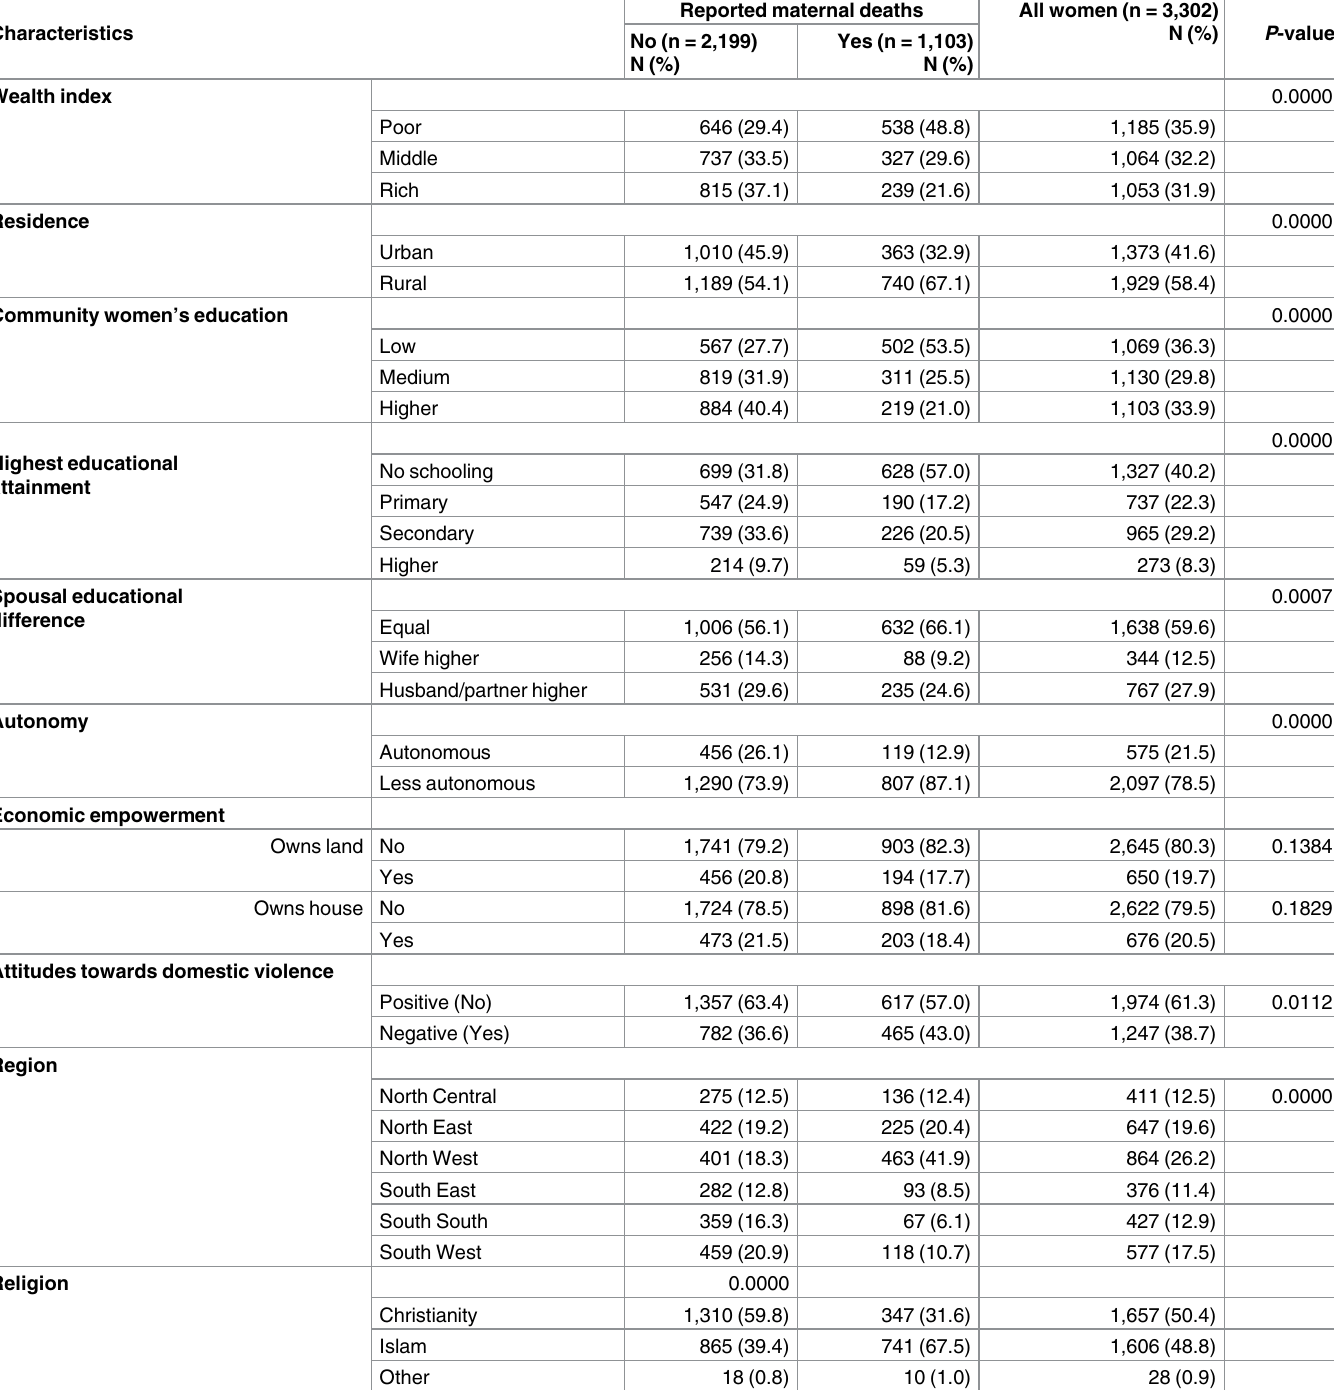
Table 3. Individual characteristics among pregnancy-related deaths identified by the direct sisterhood method, Nigeria Demographic and Health Survey 2013.